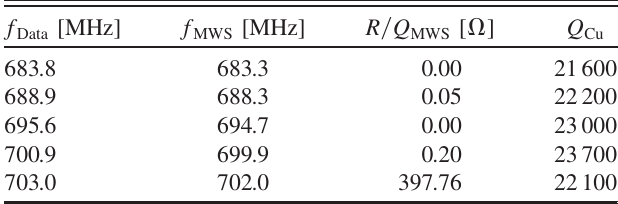
TABLE I. ERL cavity fundamental modes.